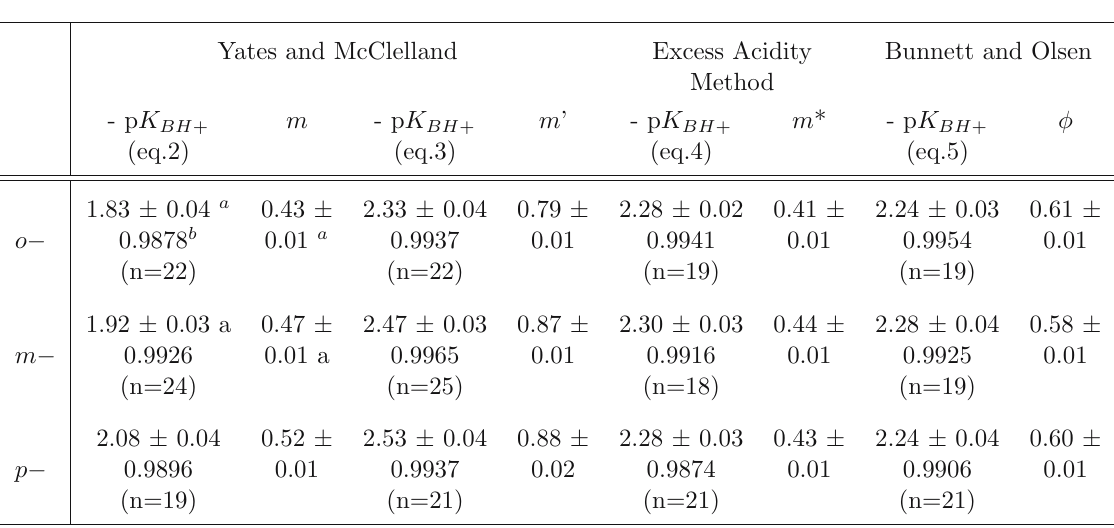
Table 5 The values of the thermodynamic dissociation constant of the protonated ben- zotoluidides, calculated from the reconstructed spectra in the region 210-350 nm, using mole fractions of B and BH +